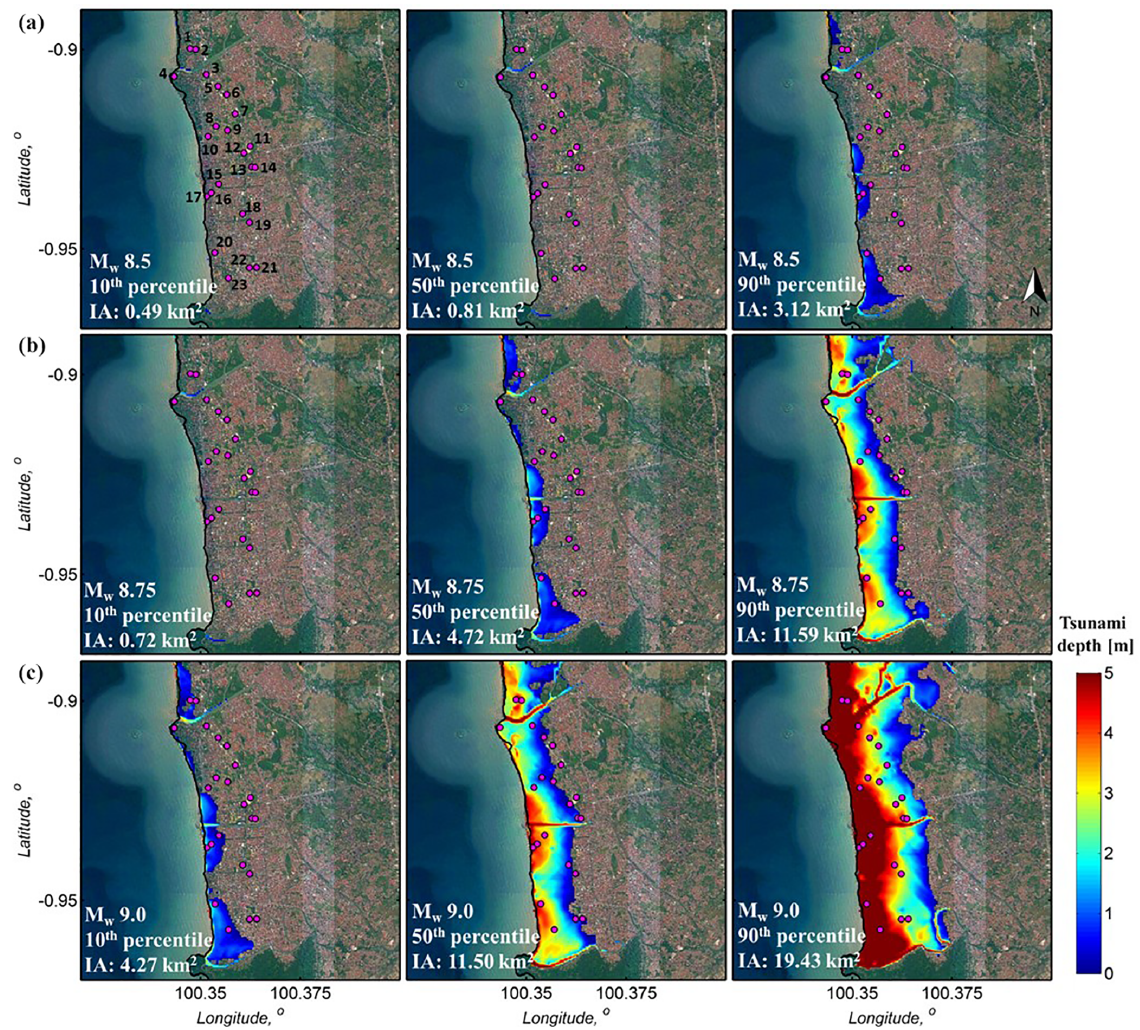
Figure 8. Inundation depth maps in Padang: (a) M w 8.5 scenario, (b) M w 8.75 scenario, and (c) M w 9.0 scenario (IA is inundation